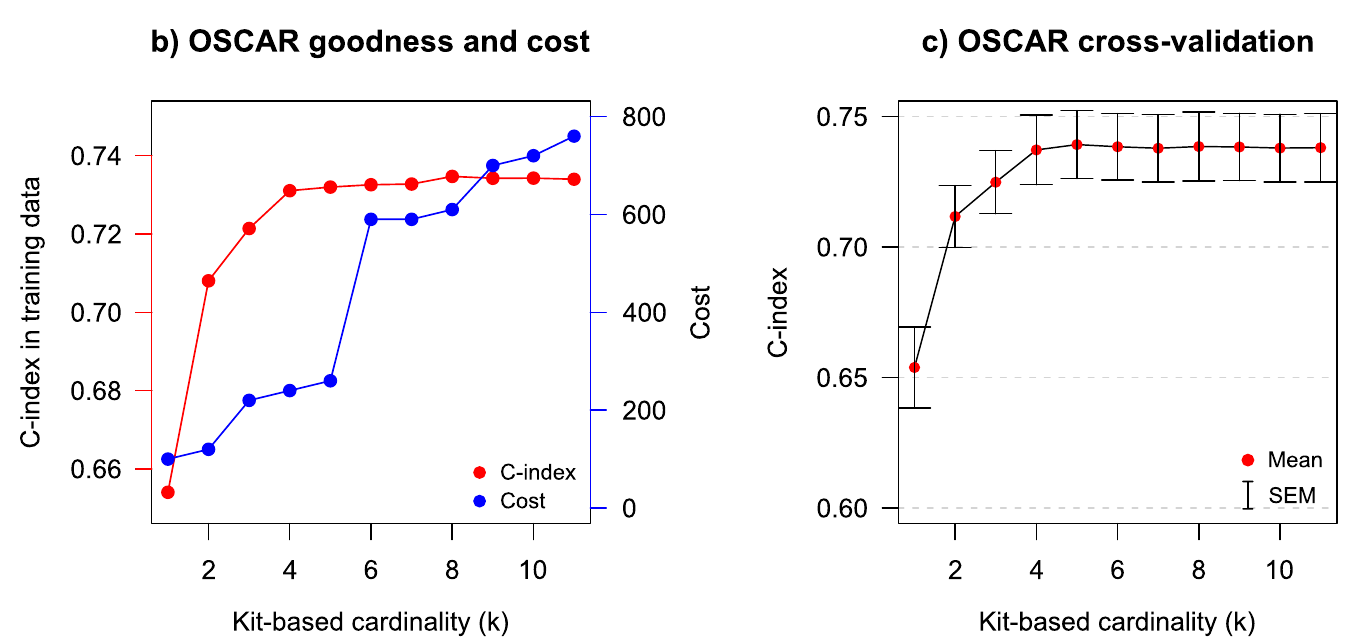
Fig 5. Model performance of OSCAR when the kit structure is used. a) BS performance, b) Goodness (C-index) and cost, c) CV performance. The red dots denote the mean values and the error bars denote the standard errors of the mean (SEM) calculated over the CV folds.